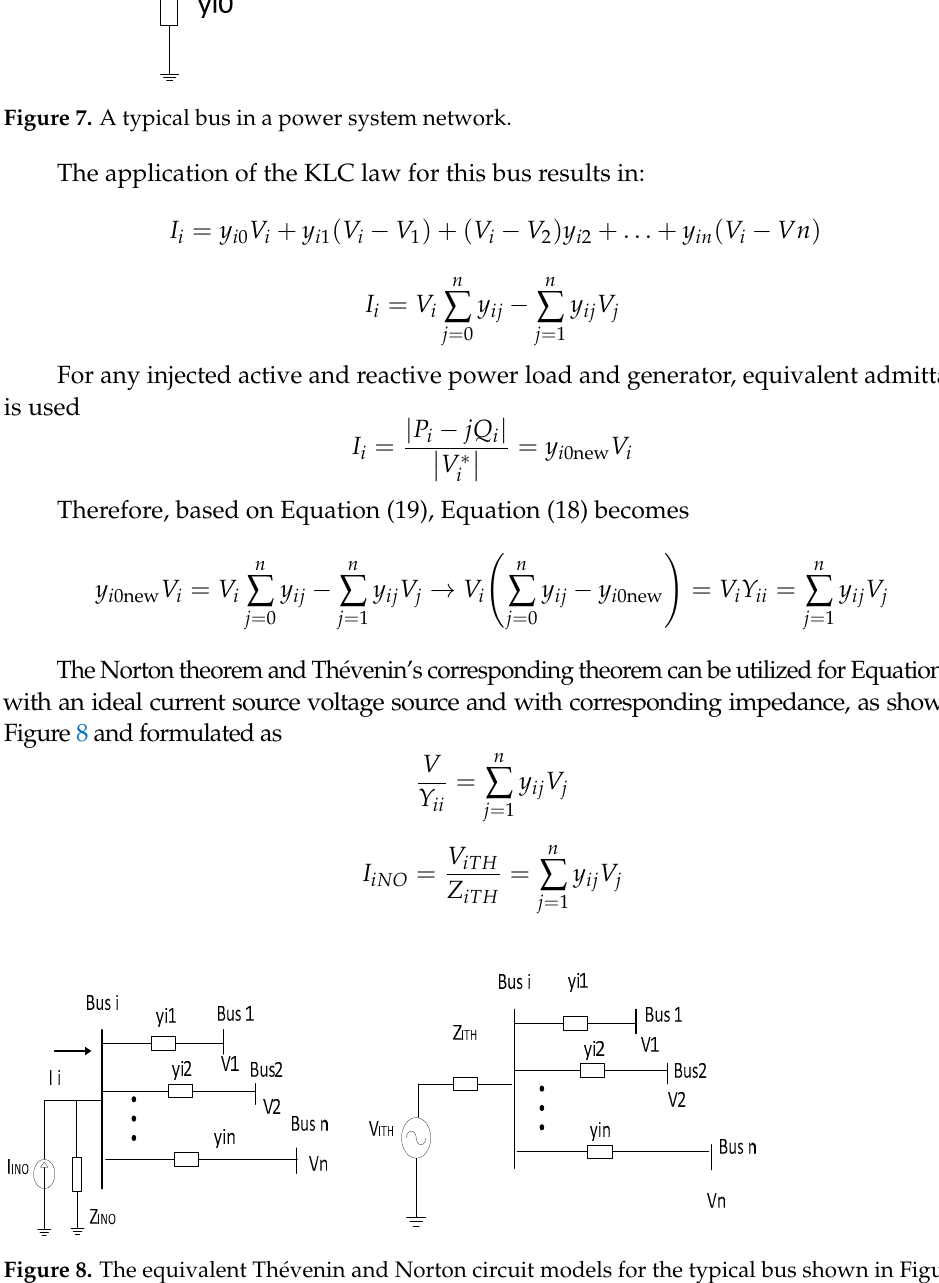
Figure 8. The equivalent Thévenin and Norton circuit models for the typical bus shown in Figure